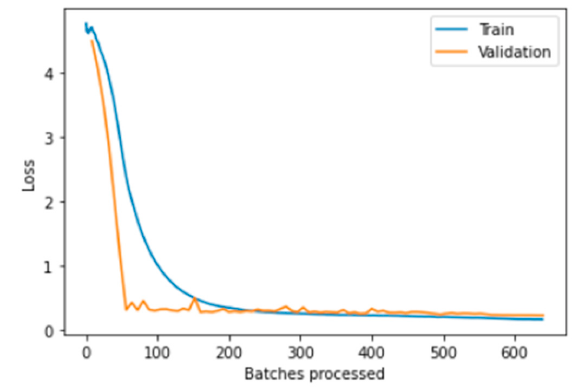
Figure 14. Loss observed during the training process.